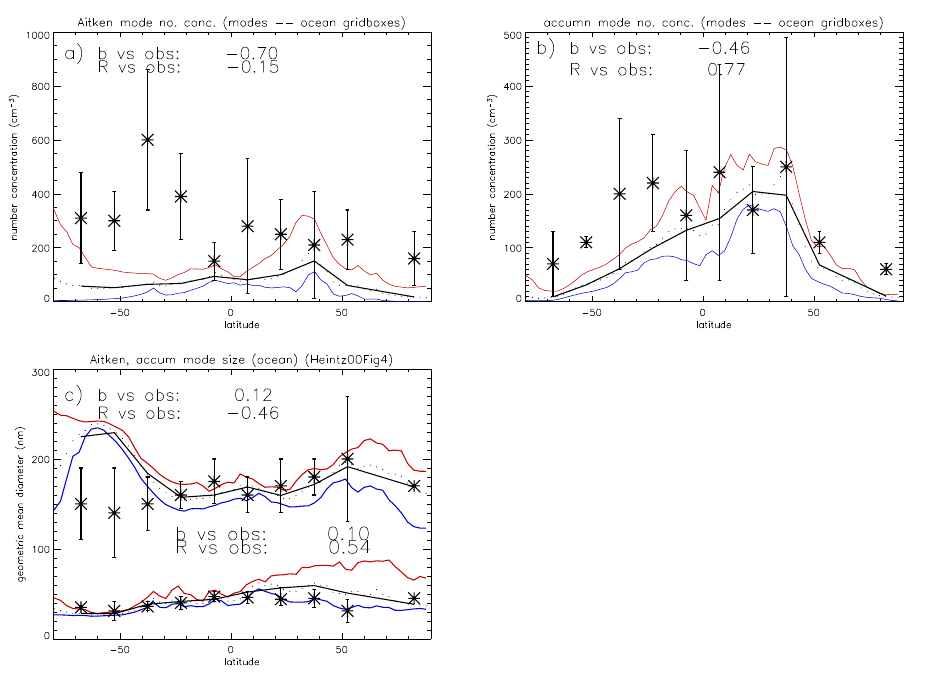
Fig. 24. Simulated marine surface zonal-mean size-resolved number concentration in (a) Aitken mode and (b) accumulation mode, and (c) geometric mean particle diameters in each mode compared to those in an observed climatology (Heintzenberg et al., 2000). Values of b and R are shown for the simulated zonal-mean values averaged into 15-degree latitude-ranges to match the observations. The black line shows simulated annual mean profile (averaged to the 15-degree grid) and the blue/red lines show minimum/maximum monthly-mean values. Dotted lines show the values on the model latitude